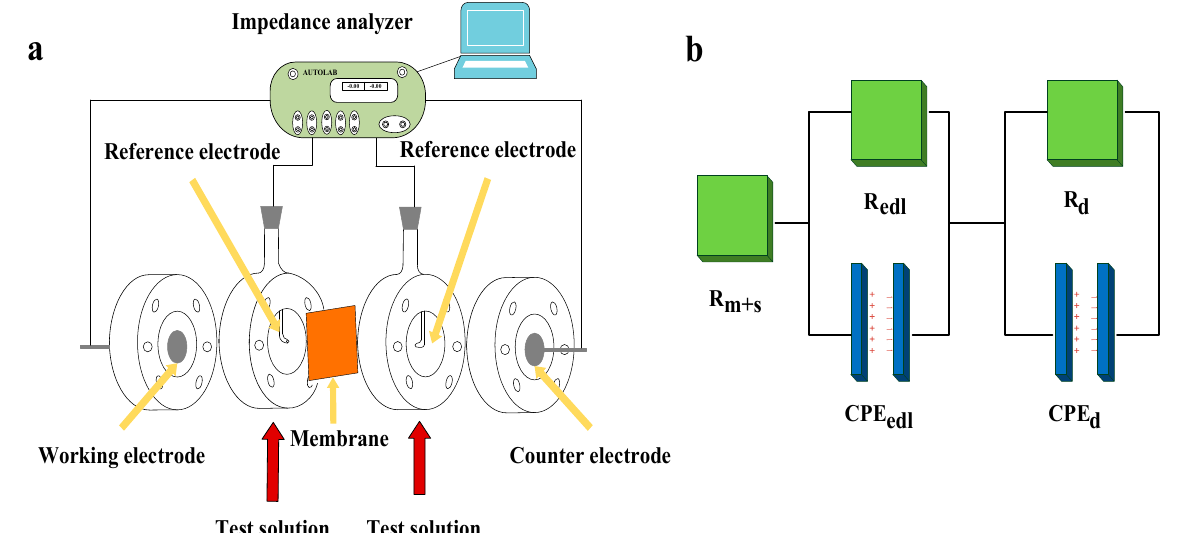
Figure 3. ( a ) Schematic of the setup used for electrochemical impedance spectroscopy measurement and ( b ) equivalent circuit for the data fitting. R m+s is the resistance of membrane and solution, R edl and R d are the resistance of EDL and DBL, respectively, and CPE edl and CPE d are the constant phase element of EDL and DBL, respectively.